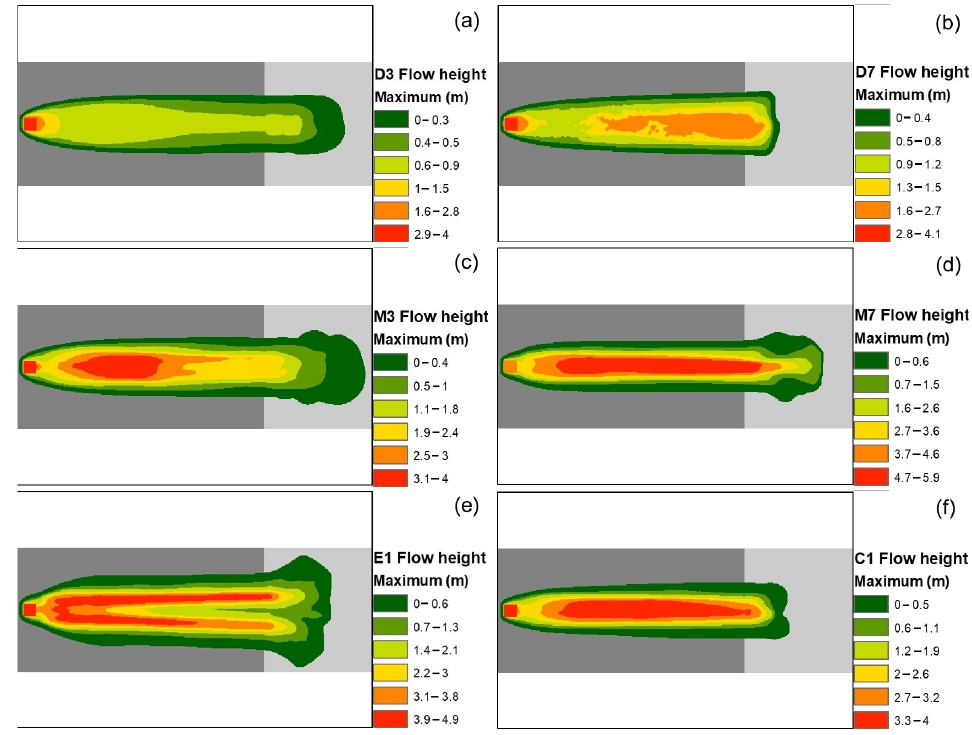
Figure 9. Maximum flowheight for ( a ) D3; ( b ) D7; ( c ) M3; ( d ) M7; ( e ) E1; ( f ) C1.